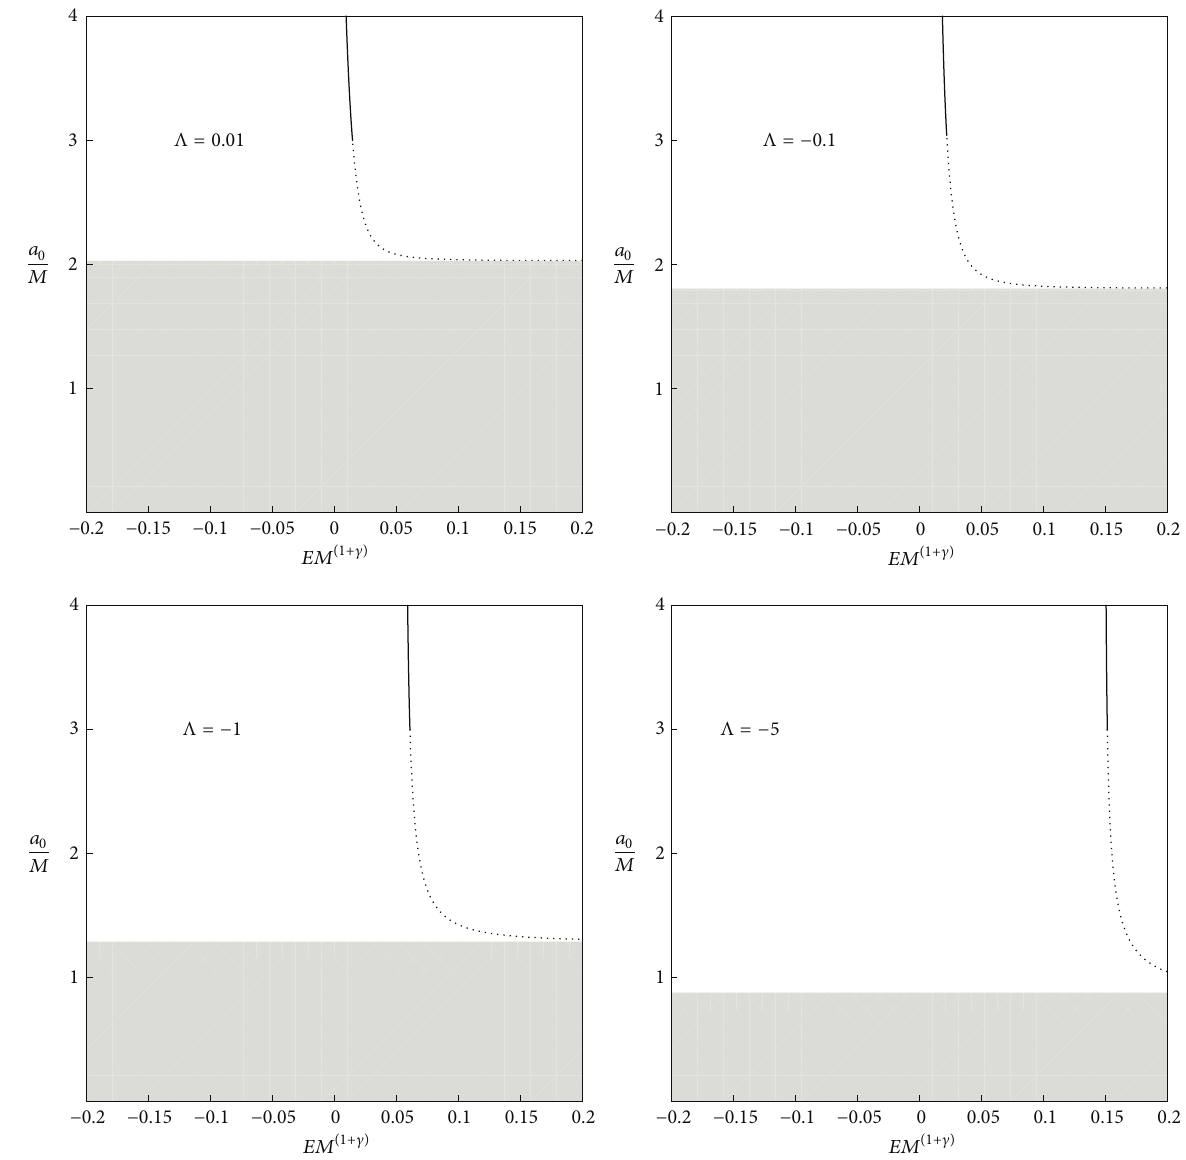
Figure 4: Plots for stable and unstable spherical TSWs with GCCG and the parameters 𝛾 = 0.2 , 𝑀 = 1 , and 𝑤 = −10 .